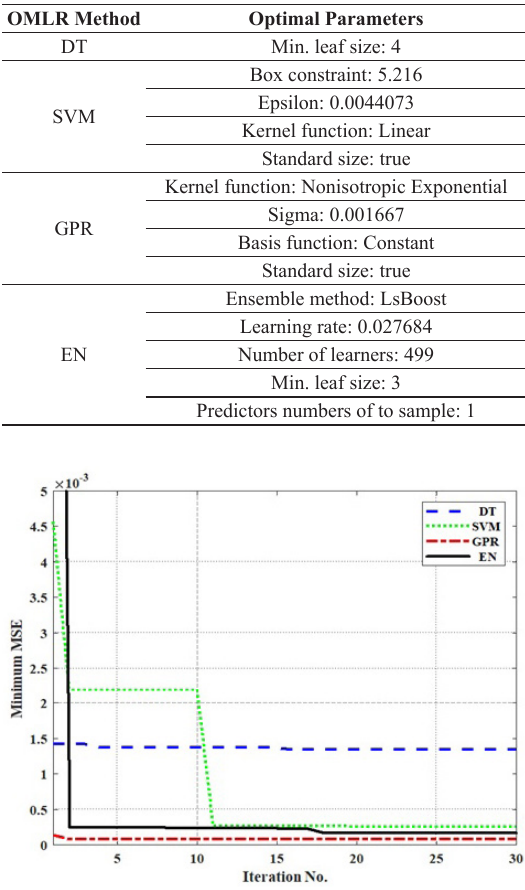
Table 3. Optimal parameters for each OMLR